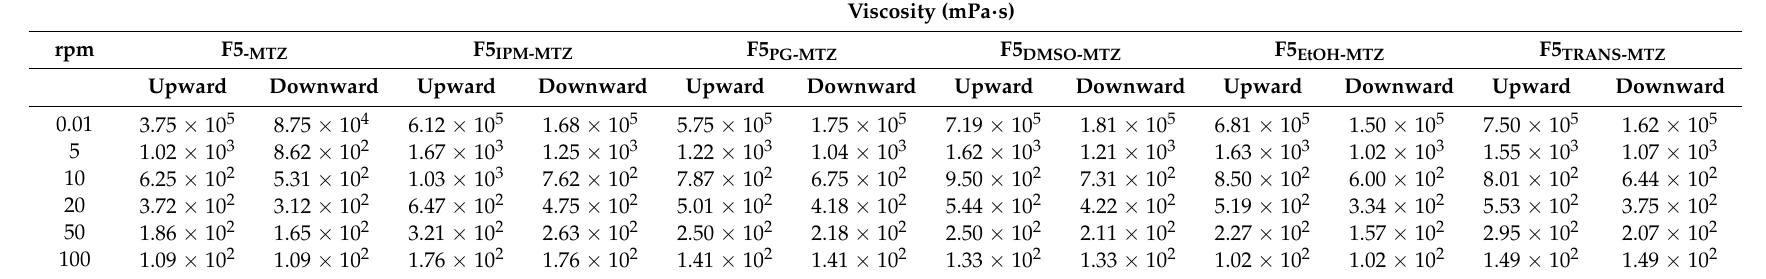
Figure 6. Thixotropic properties of the Pal-GH gel formulations. Table 4. Viscosities of the Pal-GH gel formulations.